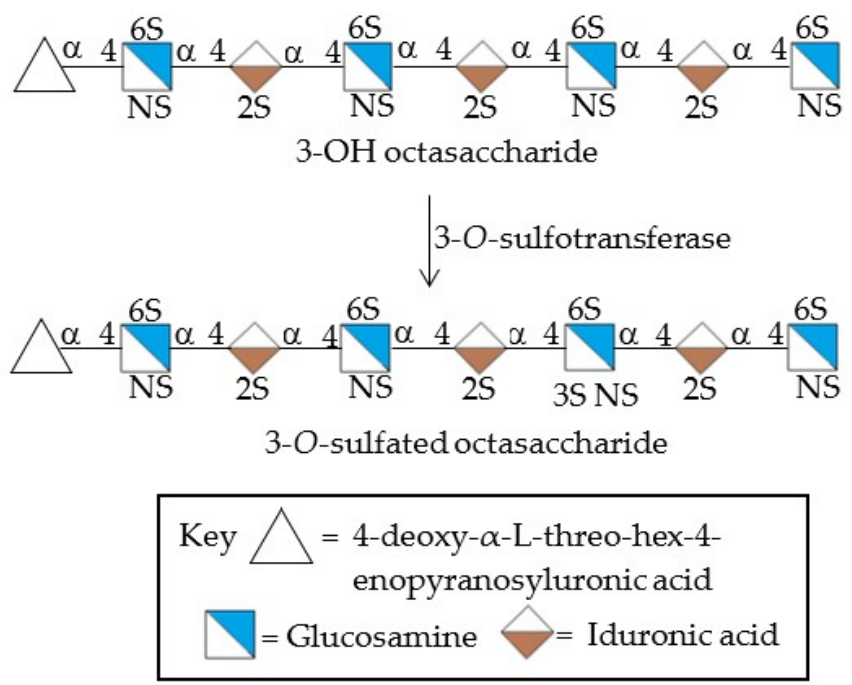
Figure 4. The preparation of 3-O-sulfated octasaccharide by 3-O-sulfotransferase. 2S, 2-O-sulfated; 3S, 3-O-sulfated; 6S, 6-O-sulfated; NS, N-sulfated. (Adapted from [310]).